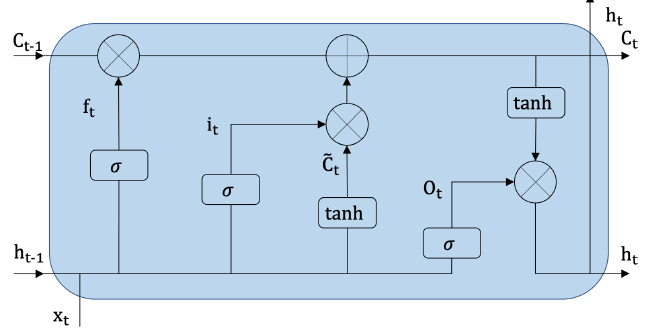
Figure 12. The structure of the LSTM